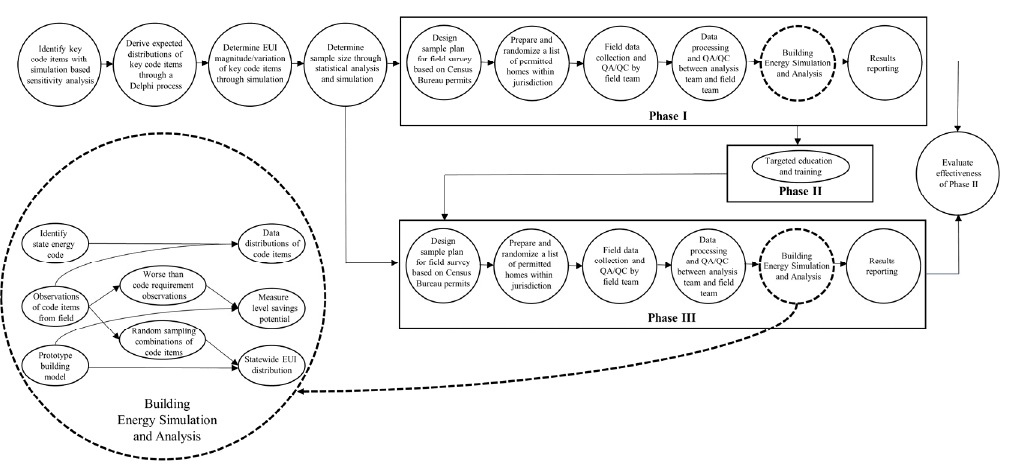
Figure 1. Methodology flowchart.